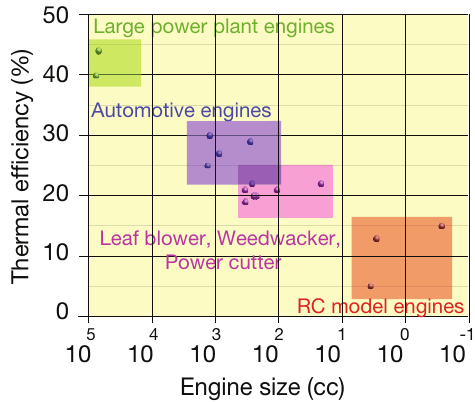
Figure 1. Thermal efficiencies of various heat engines at different length scales (partly adapted from Ref. [21]). Note that the thermal efficiency of an engine decreases with the decrease in the engine